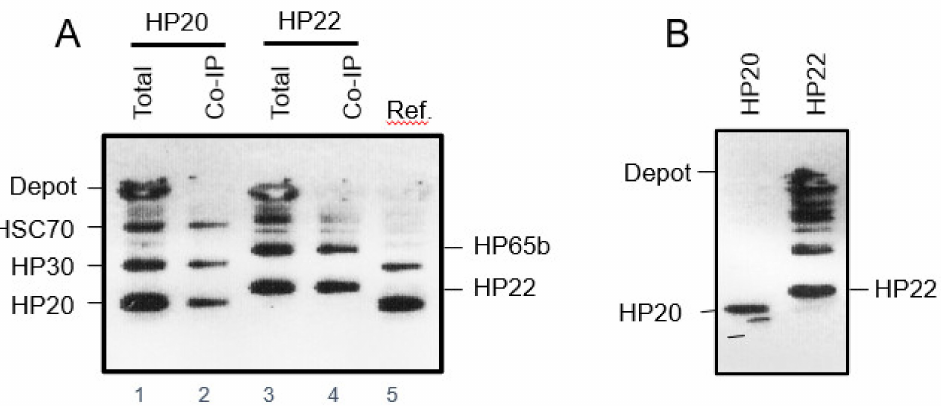
Figure 6. Identification of proteins interacting with HP22 in chloroplasts ( A ) and mitochondria ( B ), respectively. ( A ) Western blot separating plastid envelope proteins interacting with HP20-(His) 6 and HP22-(His) 6 , respectively (lanes 1 and 3), and analysis of co-immunoprecipitates obtained with antisera against HP20, HP30 and HSC70 for the HP20-(His) 6 -containing complexes (lane 2) and with antibodies against HP22 and HP65b for the HP22-(His) 6 -containing complexes (lanes 3 and 4). Lane 5 depicts the pattern of in vitro -expressed HP20 and HP30 used as reference proteins (Ref.). ( B ) Pattern of proteins interacting with HP20-(His) 6 and HP22-(His) 6 in isolated Arabidopsis mitochondria. Note the different patterns of HP22-interacting proteins relative to that in chloroplasts (cf. A) and the lack of HP20-interacting proteins in